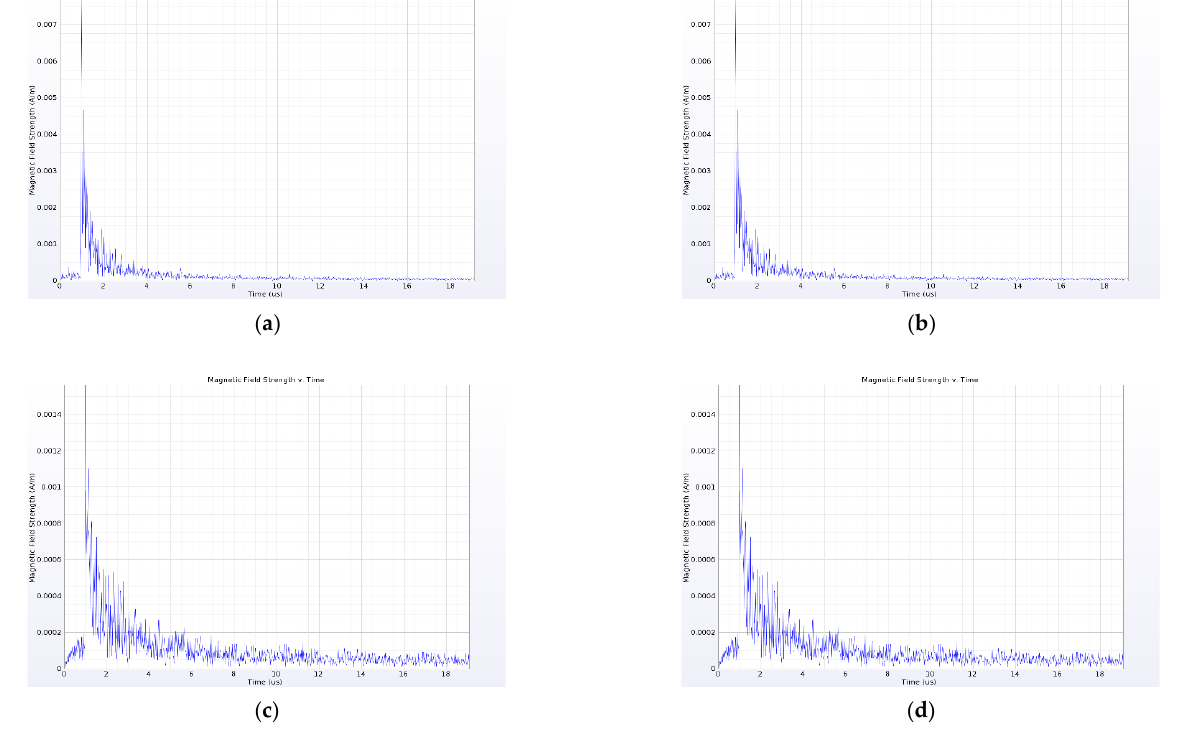
Figure 13. Effect of busbar on near-field propagation characteristics of PD electromagnetic wave signal. ( a ) magnetic field strength at point sensor 1; ( b ) magnetic field strength at point sensor 2; ( c ) magnetic field strength at point sensor 3; ( d ) magnetic field strength at point sensor 4.